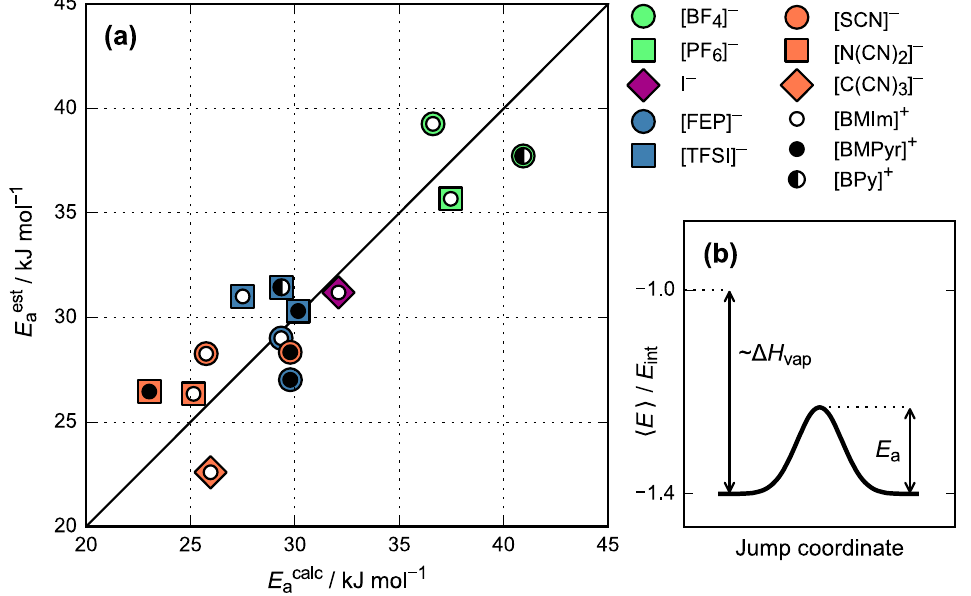
Figure 5. ( a ) The relation between the interaction energies and the activation energies of viscosity. Each of the inner circles indicates a cation and the surrounding marker indicates an anion of an ionic pair; ( b ) Potential energy profile of a diffusional jump.